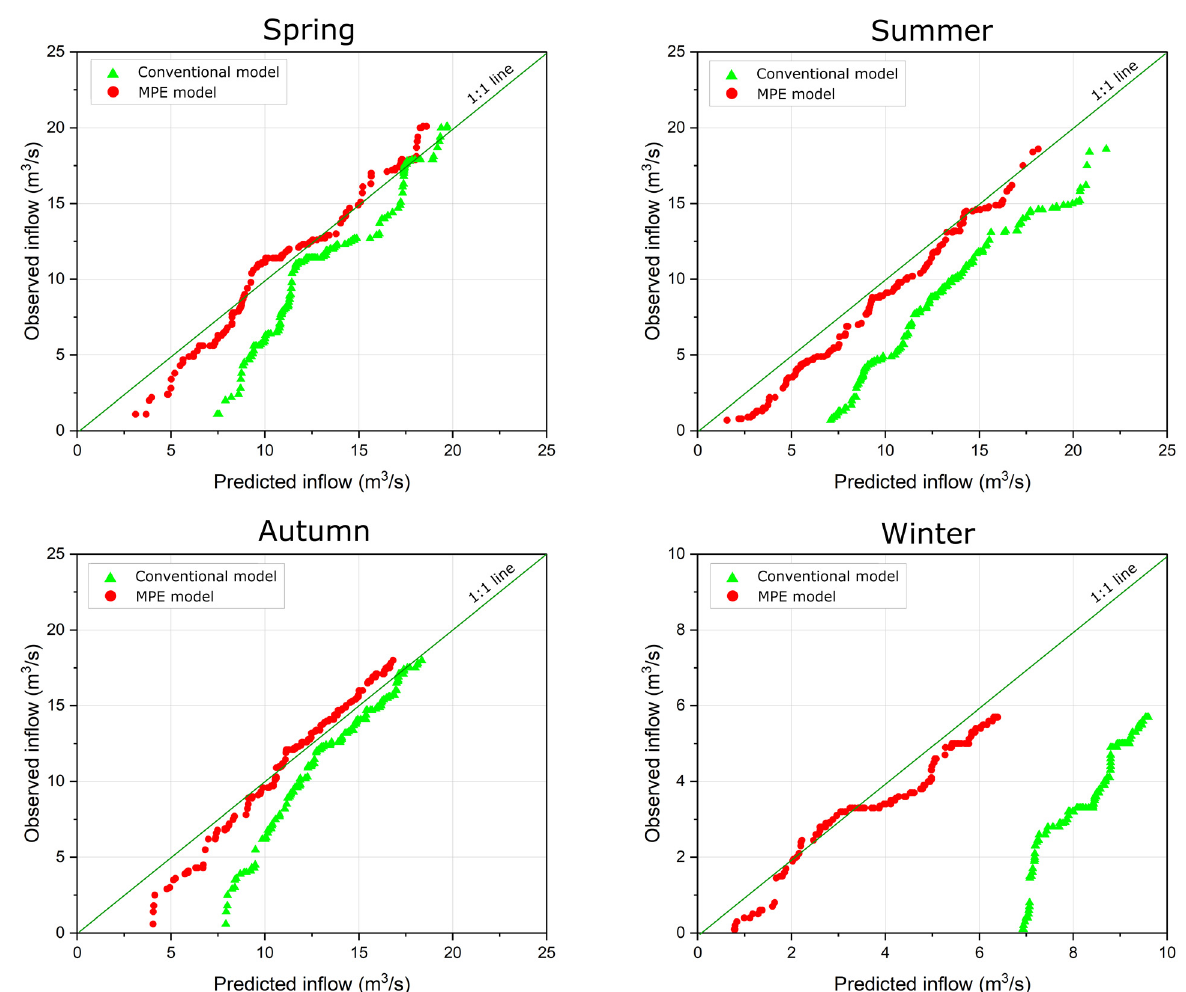
Figure 10. Scatter plots of predictions of both models for seasonal low Figure 10. Sca tt er plots of predictions of both models for seasonal low in fl ows. Table 6. Comparison of performance of both models for seasonal low in fl ows.